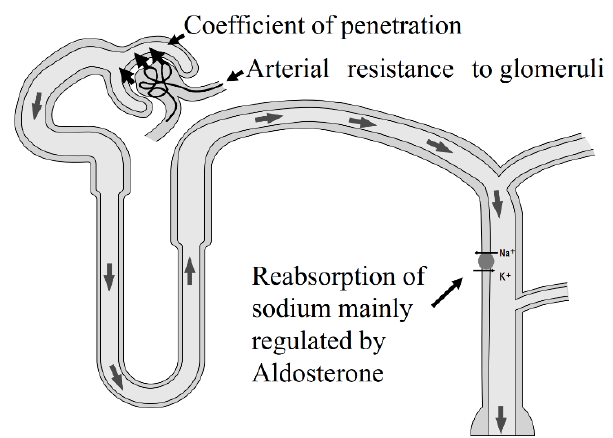
Figure 3. Determinates of blood pressure in the glomeruli. There are three elements that can determine blood pressure. One is arterial resistance to glomeruli, such as renovascular hypertension. The second is the coefficient of penetration, such as hypertension, in CKD patients. The third element is reabsorption of sodium in distal tubules, regulated primarily by aldosterone, such as primary aldosteronism. In CKD patients, the coefficient of penetration is not normal because this coefficient depends on the effective surface of the glomeruli.